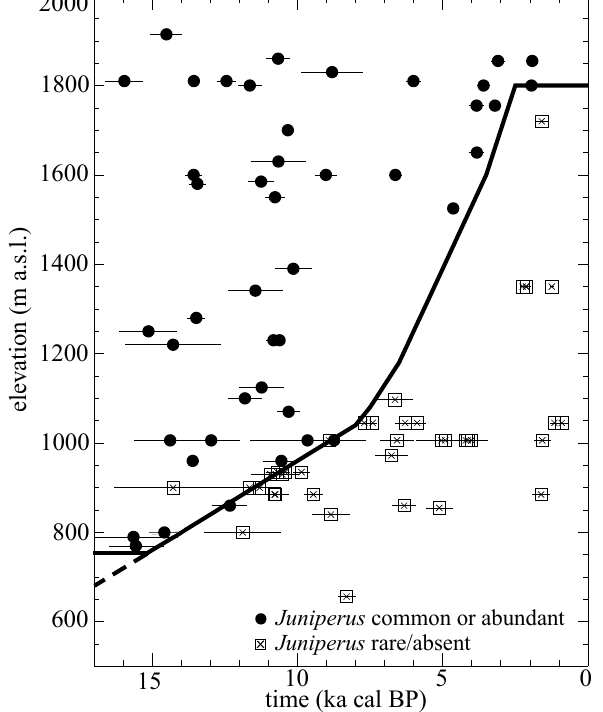
Figure 3. Plot of every midden in the North American Midden Database (Strickland et al., 2005) between 34 and 37 ◦ N latitude, 117.5 and 115 ◦ W longitude, and 500 and 2000ma.s.l., and 1 and 17ka in age (cal BP; 14 C years were converted using IntCal09 of Reimer et al. (2009); 95% confidence intervals are shown) with Ju- niperus common/abundant (closed circles; total of 46 samples) and Juniperus rare/absent (open squares; total of 41 samples). In the lat- ter cases, Juniperus is specifically noted as absent or a complete taxa list is available that does not include Juniperus . The solid curve is the lower elevational limit of woodlands adopted in the model. The dashed line indicates that the lower limit of common/abundant Ju- niperus is poorly constrained from 17 to 15ka cal BP. Figure 4. (a) Shaded-relief map of the study area. (b) Color map of